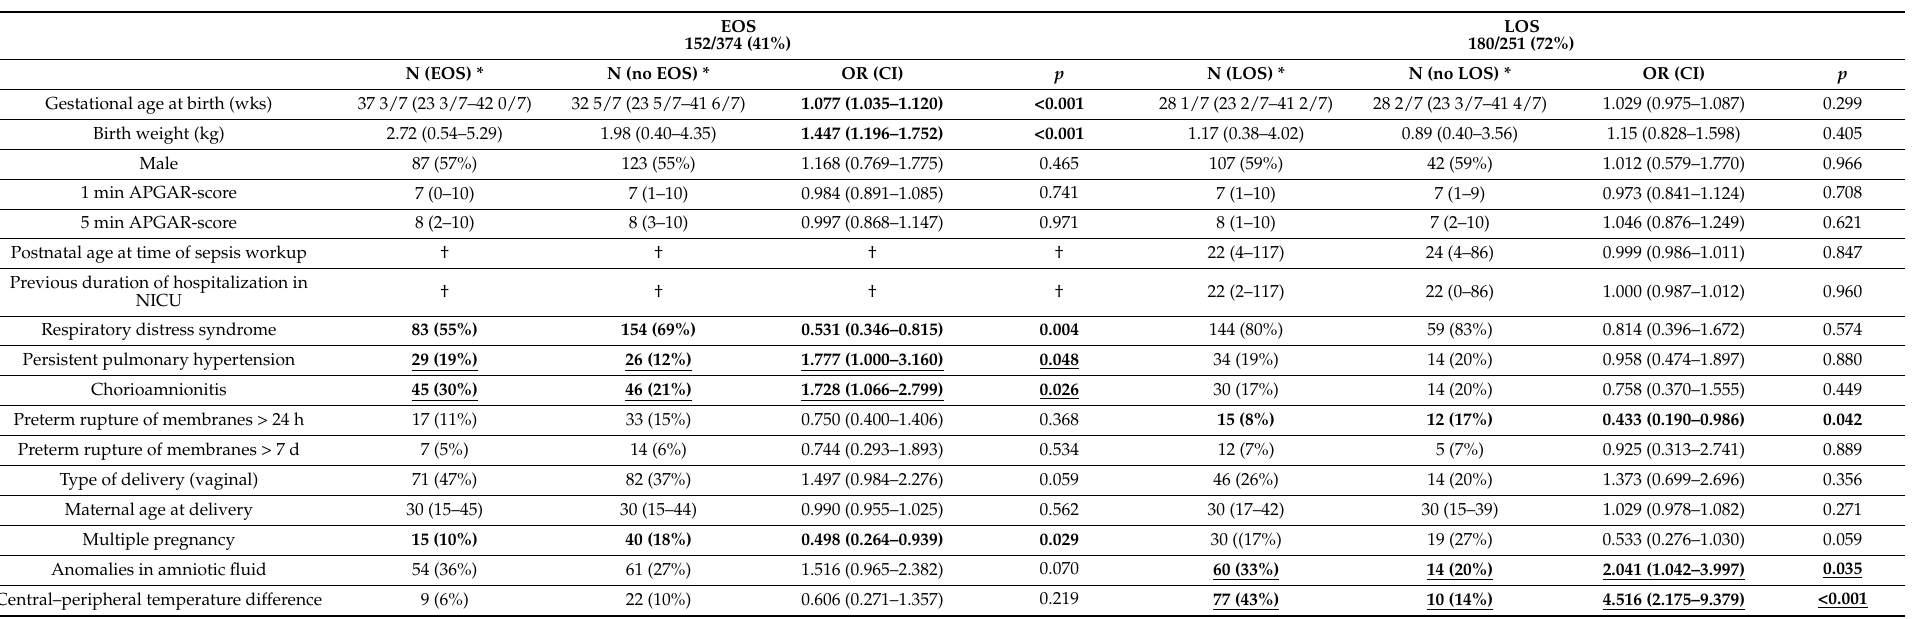
Table 1. Associations between anamnestic and clinical data and occurrence of infection episodes. Chi-square tests or logistic regressions were used to detect possible linkages to the sepsis workup. Significant results are shown in bold. Significant factors in the multivariate regressions are also underlined. EOS 152/374